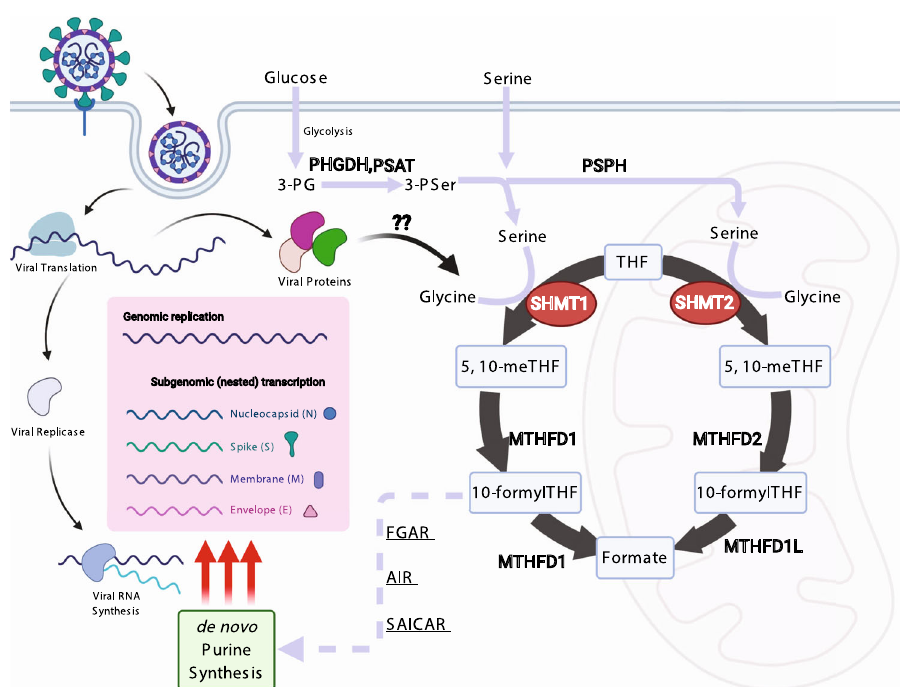
Fig. 4 Schematic of SARS-CoV-2 induced one-carbon metabolism in support of viral replication. SARS-CoV-2 induces glycolysis and one-carbon metabolism at the post-transcriptional level in newly infected cells. Serine metabolism, particularly by cytosolic SHMT1 produces carbon units for de novo purine synthesis in support of massive viral subgenomic RNA synthesis, non-structural protein expression, and viral